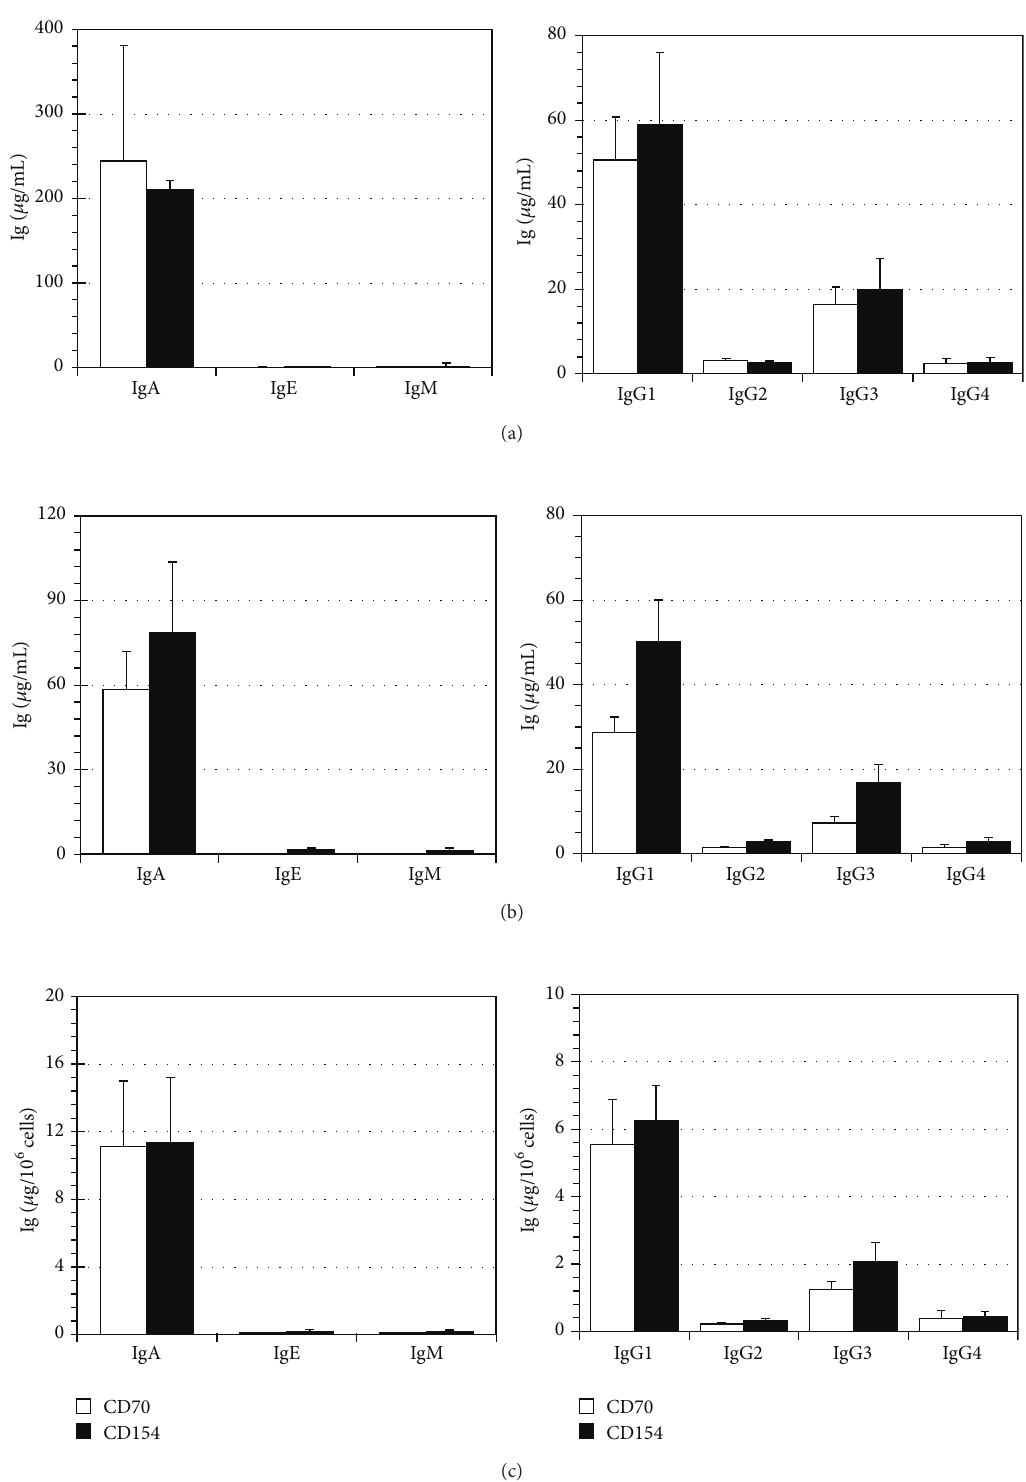
Figure 4: In vitro generated plasma cells secrete high level of IgA and IgG. Immunoglobulin secretion in supernatants was measured by the Bio-Plex human isotyping kit. The cumulated Ig concentration was determined on (a) day 5 (D5) after the transition phase and (b) day 14 (D14) at the end of differentiation. (c) Relative secretion was determined on D14 by normalizing immunoglobulin concentrations with total cell count on day 5, corresponding to the plateau in proliferation. The results are presented as the mean ± S.E.M. of 6 independent samples. No differences were observed between CD70 and CD154